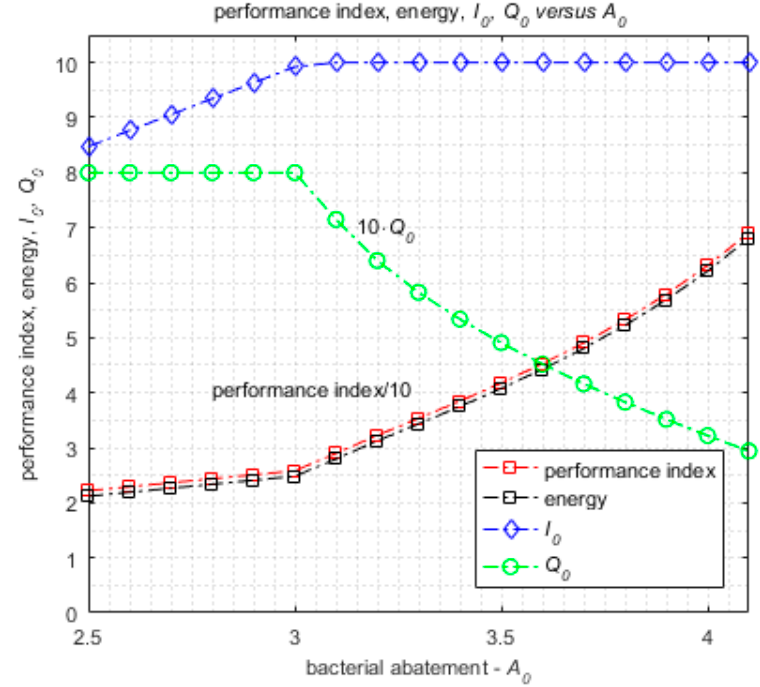
Figure 6. Optimal solutions as functions of A 0 .